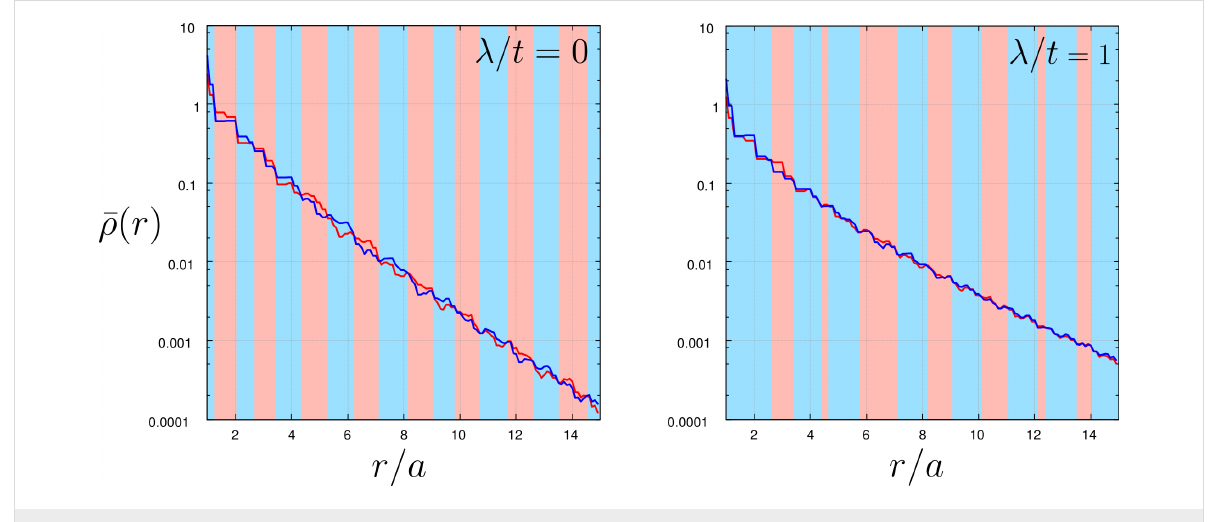
Figure 3: Hole-like (blue line) and electron-like (red line) displaced moving average as a function of the radial distance r from the impurity site obtained for | J | < J c using δ r = 0.5 a . The blue and red background color indicates the dominant type (hole or particle) of the YSR states at a given dis- tance r . The left and right panels correspond to λ = 0 and λ = t ,